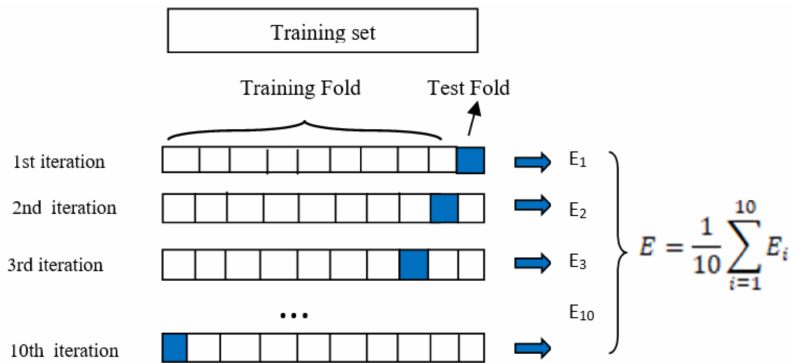
Figure 3. 10-fold Cross-validation technique